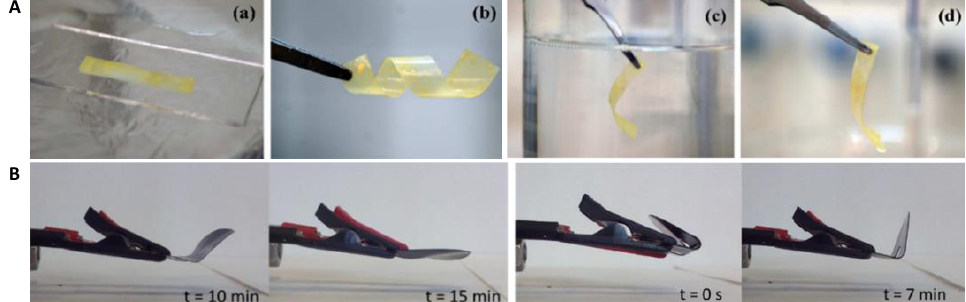
Figure 2. ( A ) Pictures showing the shape memory behavior of a polyether block amide thermoplastic elastomer with 20 wt % electrospun polyvinyl alcohol as a filler. ( a ) The sample was heated to 90 °C and formed into a spiral shape, and the temporary shape was fixed by cooling to ambient temperature ( b ). The original shape was recovered ( c , d ) upon heating the sample again to 90 °C in silicon oil [59]. ( B ) Electroactive shape recovery behavior of the carboxylated nitrile rubber nanocomposite with 15 phr of CNTs as a function of the time of application of a constant voltage of 50 V [60]. Reprinted with permission from [59,60].